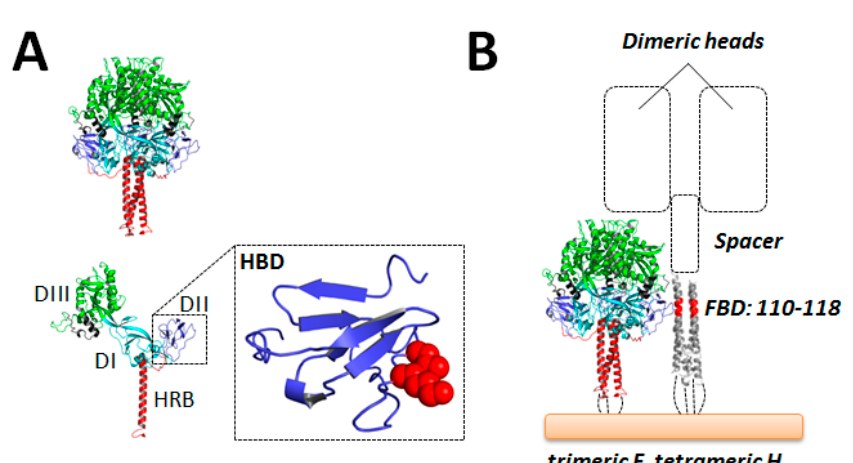
Figure 3. Model of MeV H/F assembly. ( A ) Representation of MeV F as a trimer (upper panel) or monomer (lower panel) with the DI, DII and DIII domains color-coded as indicated in Figure 1A. The highlighted box shows a zoom of the Ig-like domain proposed to be important for interaction with H (HBD). The two key hydrophobic residues proposed (in CDV F) to control H interaction are represented as spheres and color-coded in red (l506 and K508) [133]. Images were generated using the PyMol software package (V 1.0, DeLano Scientific, Palo Alto, California, USA); ( B ) Putative H/F assembly. The presumptive HBD of one F-monomer is aligned with the proposed H-stalk segment involved in a short range interaction with F (FBD). The “spacer” H-stalk module, which enables positioning of the two dimeric head units above the F trimer, is represented as a box.